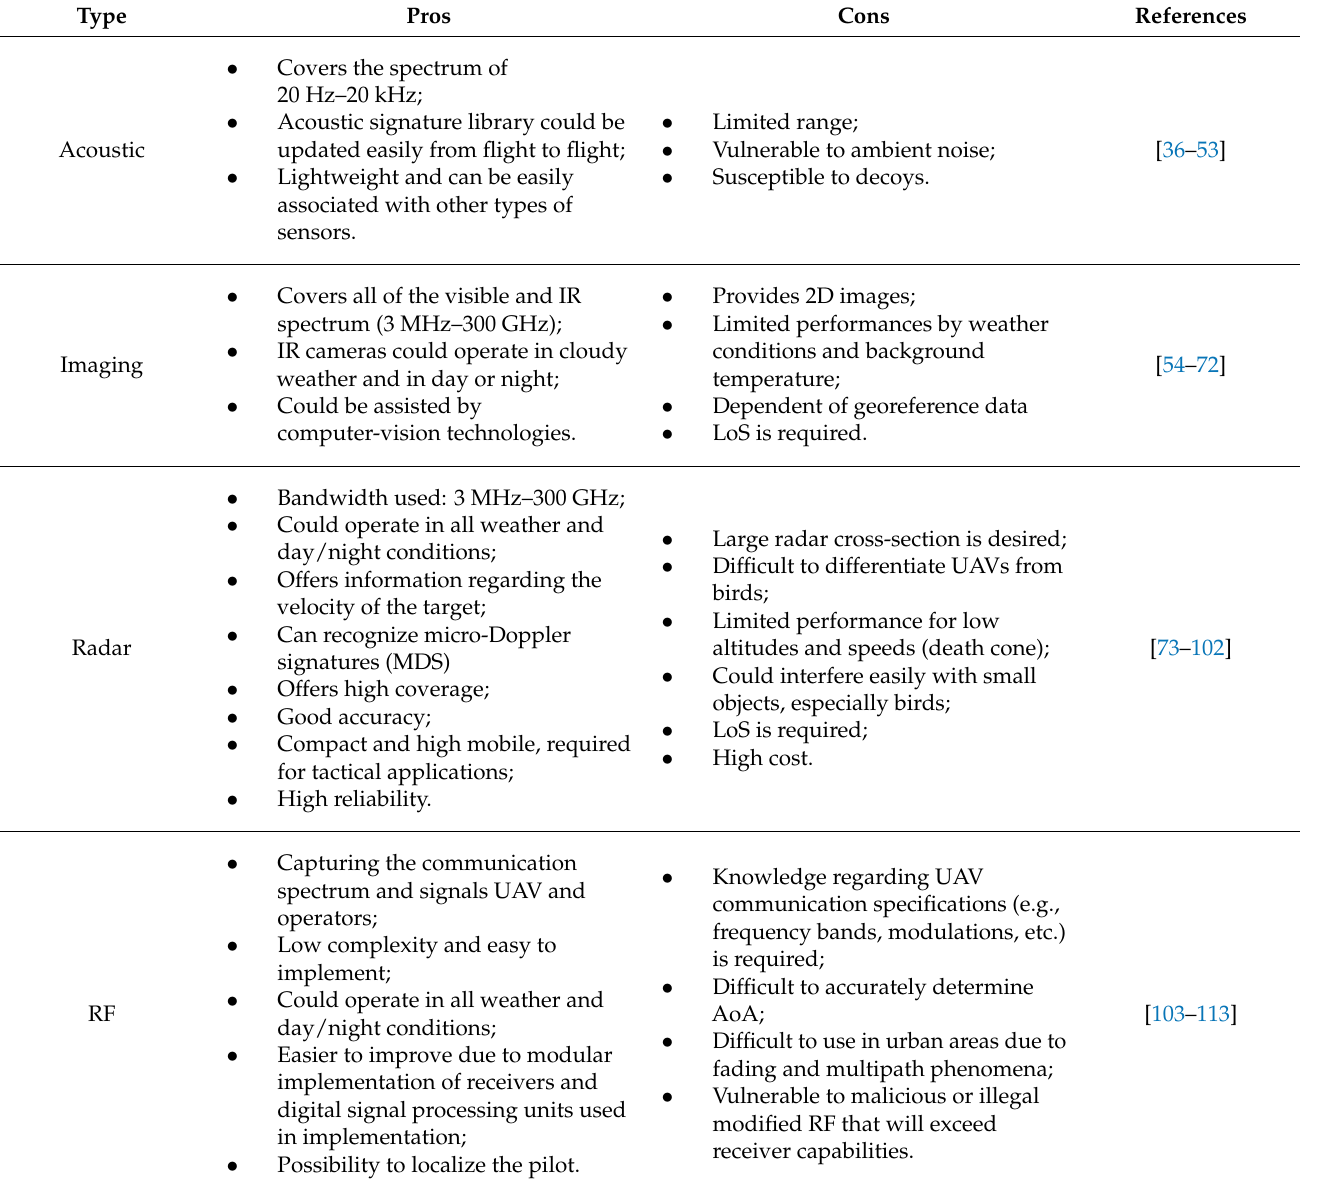
Table 5. Pros and cons of sensors used in